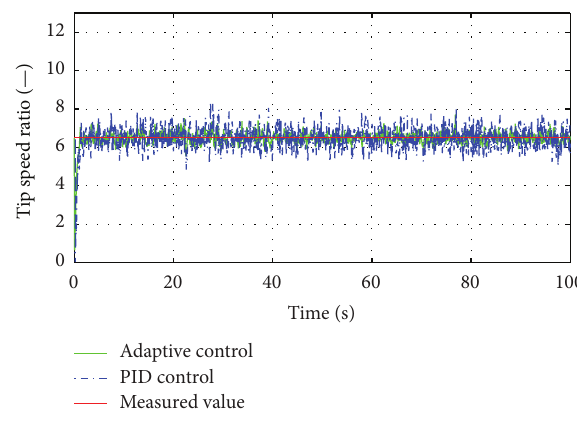
Figure 12: Comparison of tip speed ratio tracking.